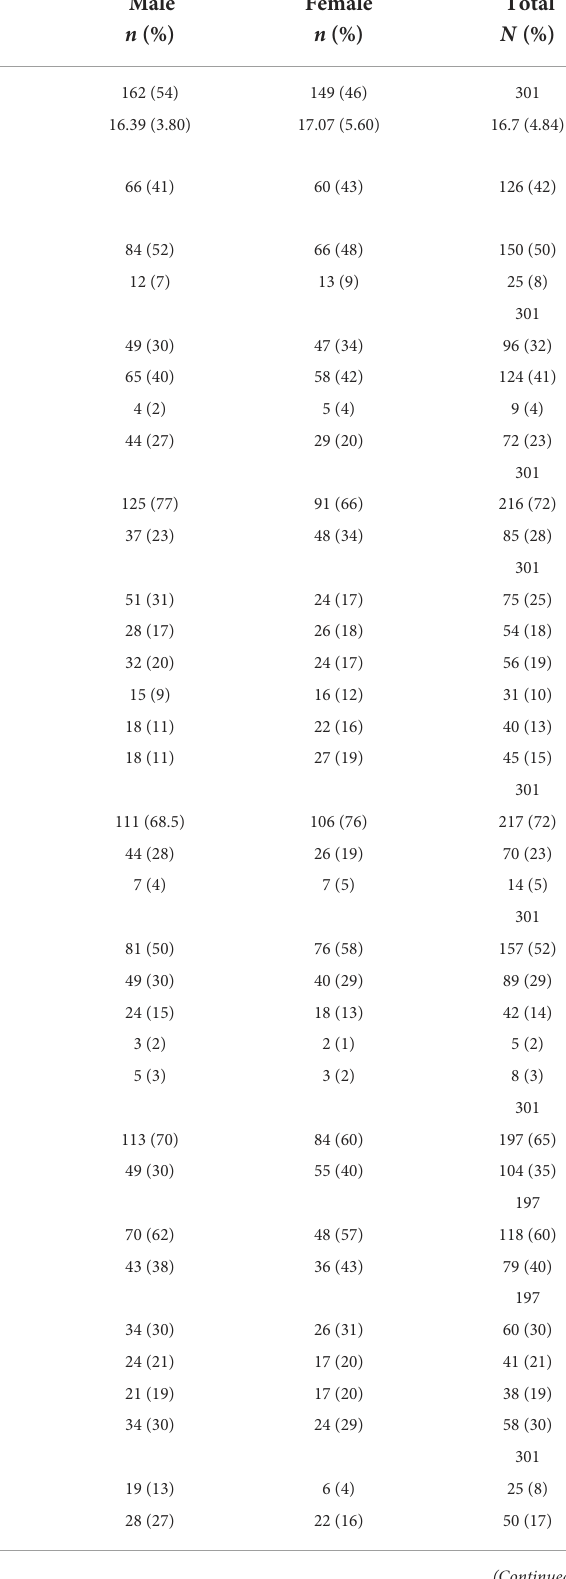
TABLE 1 Demographics and safety habits of participating students pre-program ( N = 301).